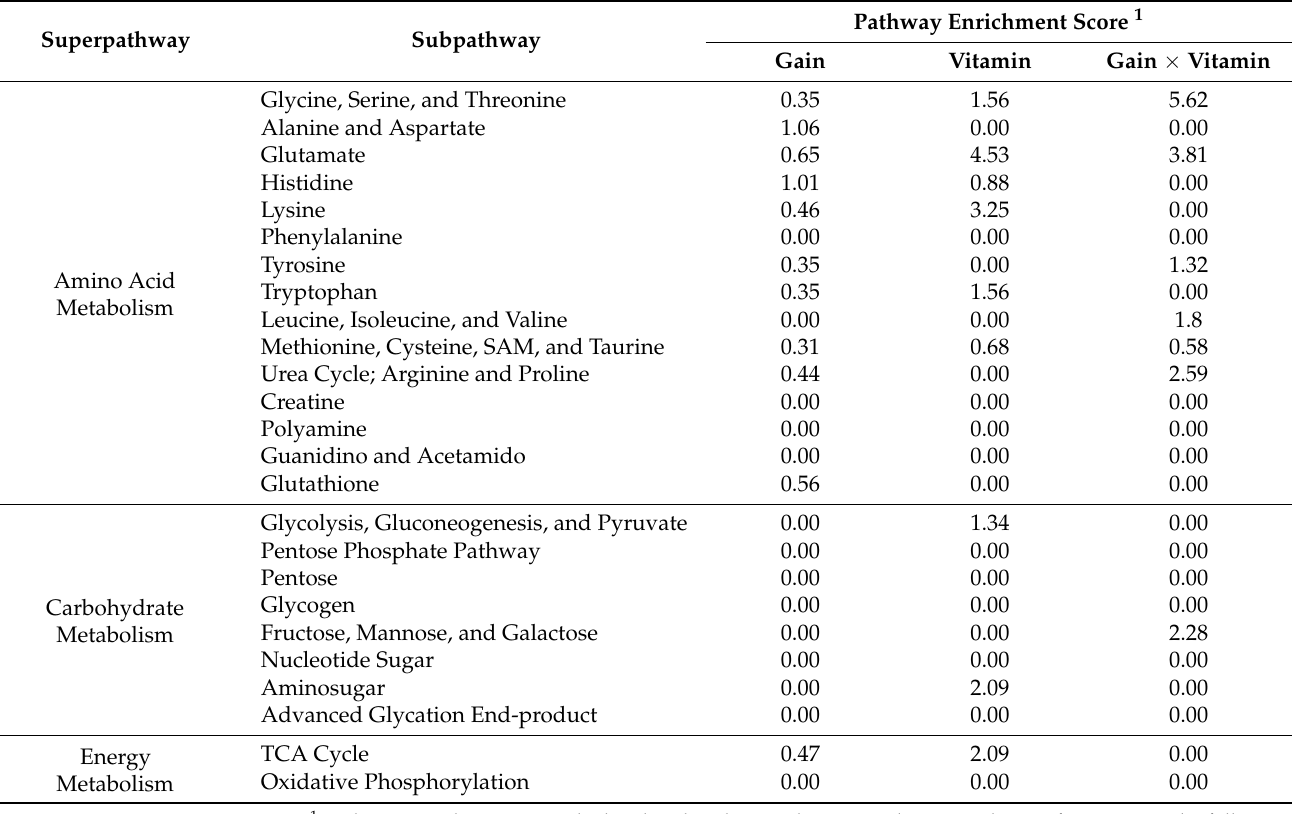
Table 1. Pathway enrichment scores for each pathway identified. Pathways with enrichment scores >1 have more metabolites with statistically significant fold changes compared to all other pathways within the